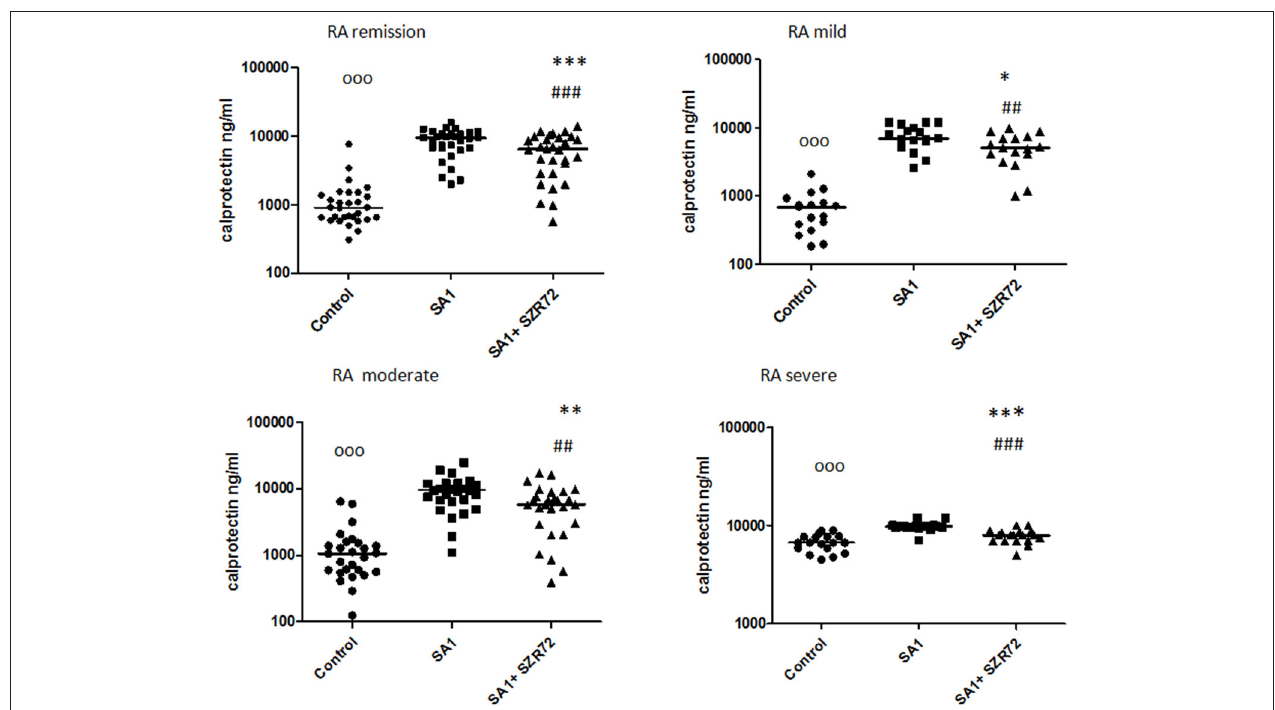
FIGURE 7 | The effect of SZR72 on calprotectin production in human whole blood cells of various groups of patients with RA stimulated by heat-inactivated Staphylococcus aureus. Each dot represents the individual value for one subject, and the horizontal lines denote the medians. Significance was determined by the Friedman’s test. Remission group: n = 30, p < 0.0001; control vs. SA1, ooo p < 0.001; control vs. SA1 + SZR 72, ### p < 0.001; SA1 vs. SA1 + SZR72, *** p < 0.001 according to the Dunn’s post-test. Mild group: n = 18, p < 0.0001; control vs. SA1, ooo p < 0.001; control vs. SA1 + SZR72, ## p < 0.01; SA1 vs. SA1 + SZR 72, * p < 0.05 according to the Dunn’s post-test. Moderate group: n = 27, p < 0.0001; control vs. SA1, ooo p < 0.001; control vs. SA1 + SZR 72, ## p < 0.001; SA1 vs. SA1 + SZR 72, ** p < 0.01 according to the Dunn post’s test. Severe group: n = 18, p < 0.0001; control vs. SA1, ooo p < 0.001; control vs. SA1 + SZR72, non-significant; SA1 vs. SA1 + SZR72, *** p < 0.001 according to the Dunn’s post-test.